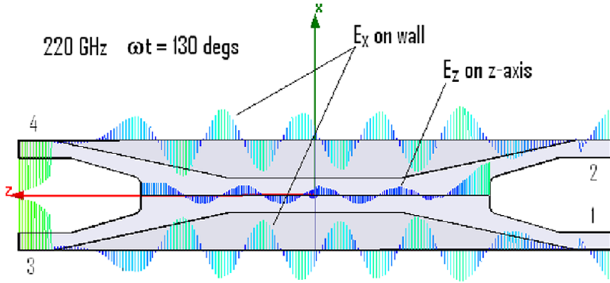
shown).FIG. 21. (Color) Electric field E -dependence on central lines on side conducting walls ( x (cid:3) (cid:16) 0 : 31 mm and y (cid:3) 0 ) and on z -axis ( x (cid:3) 0 and y (cid:3) 0 ). On the conducting walls, E (cid:3) E z -axis, E (cid:3) E . It is seen that there is a (cid:3)= 2 -phase difference z and E ; the interaction region contains about 4.5 between E x z wave peaks, and the ratio of the height of E -amplitude is about 4, compared with 4.2 from height of E z analytic